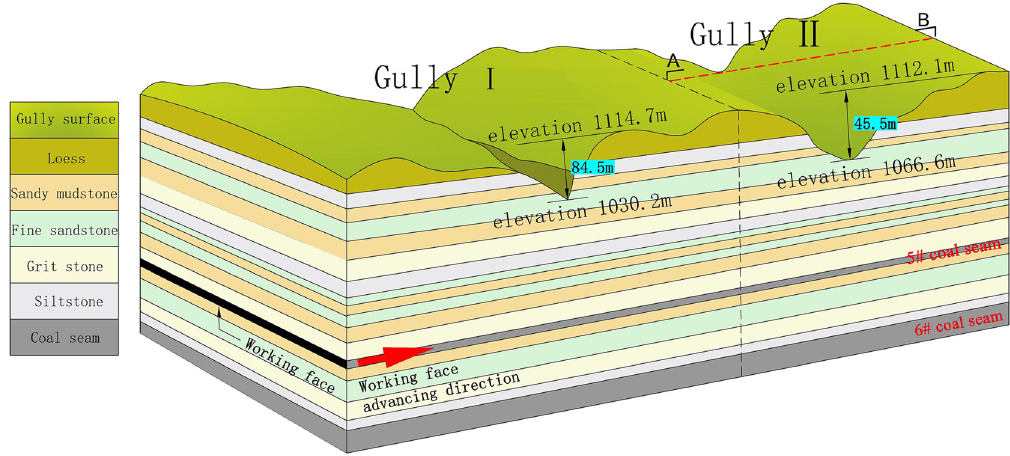
Fig 1. Schematic diagram of the occurrence state of loess gullies on the surface.